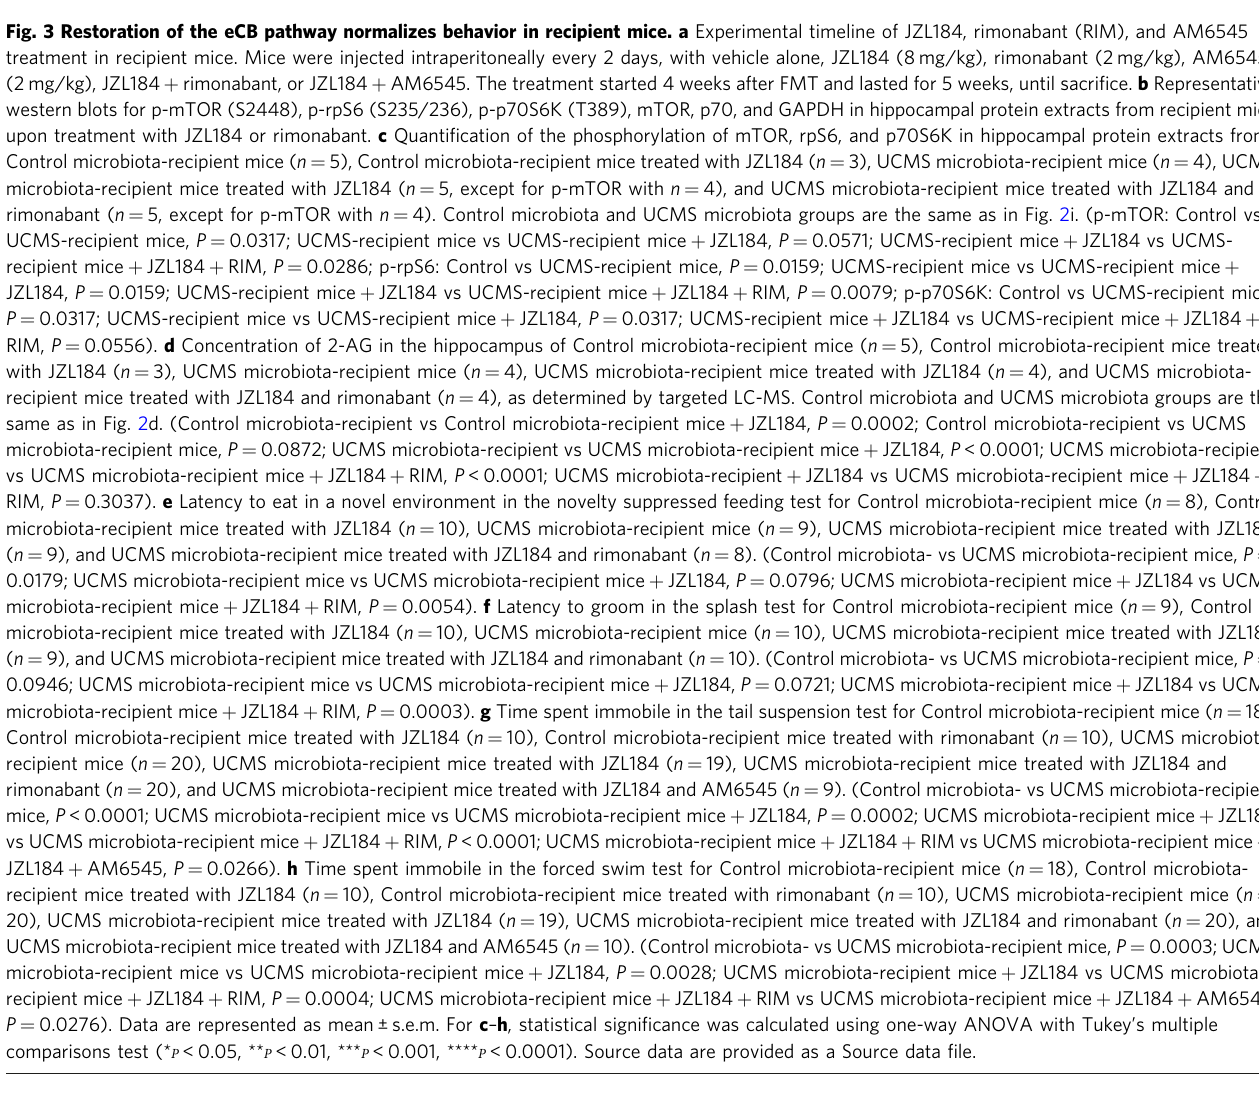
Fig. 3 Restoration of the eCB pathway normalizes behavior in recipient mice. a Experimental timeline of JZL184, rimonabant (RIM), and AM6545 treatment in recipient mice. Mice were injected intraperitoneally every 2 days, with vehicle alone, JZL184 (8 mg/kg), rimonabant (2 mg/kg), AM6545 (2 mg/kg), JZL184 + rimonabant, or JZL184 + AM6545. The treatment started 4 weeks after FMT and lasted for 5 weeks, until sacri fi ce. b